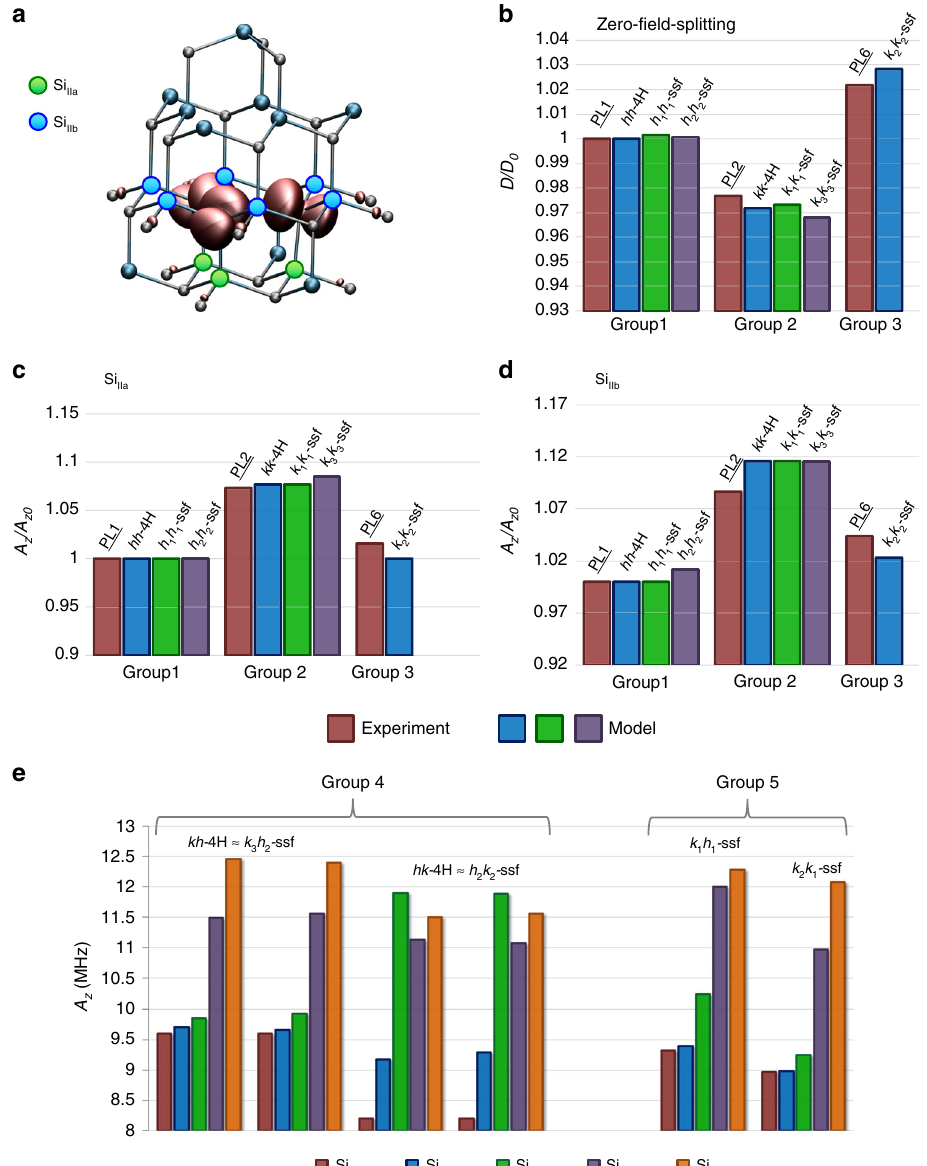
Fig. 3 Spin coupling parameters of different divacancy con fi gurations. a Spin density of an axial divacancy. Blue and green fi lled circles indicate the second neighbor silicon sites for which the hyper fi ne tensors were calculated. b The calculated and experimentally measured relative ground-state zero- fi eld splitting parameter for each axial symmetric defect. D hh -4H con fi guration and PL1 center in the calculation of the theoretical 0 is equal to the ZFS of and experimental parameters, respectively. The experimental results are reported in ref. 40 . c , d Relative hyper fi ne parameters of Si IIa and Si IIb neighboring nuclei sites, which are depicted in a . A z 0 is equal to the hyper fi ne splitting of hh -4H con fi guration and PL1 center in the calculation of the theoretical and experimental parameters, respectively. e Hyper fi ne splitting of basal plane divacancy con fi gurations. Due to the low symmetry of basal plane con fi gurations, we distinguish symmetrically non-equivalent sites, Si IIa-1 and Si IIa-2 , and Si IIb-1 , Si IIb-2 , and Si IIb-3 , in the neighbor shells of Si IIa and Si IIb shown in a